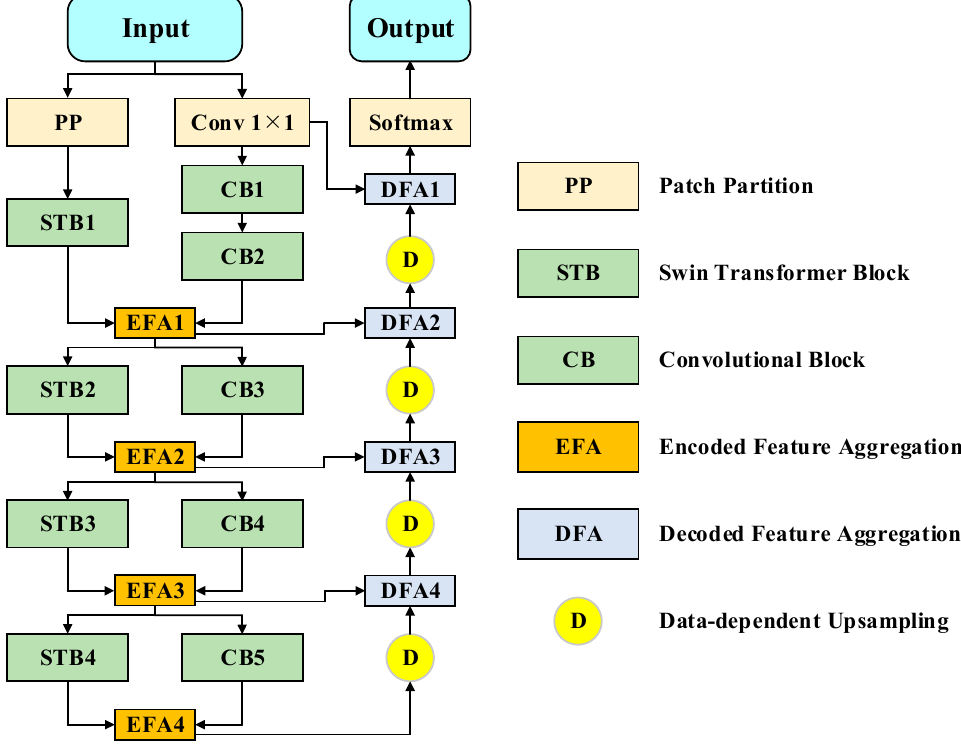
Figure 2. The Framework of ICTNet.